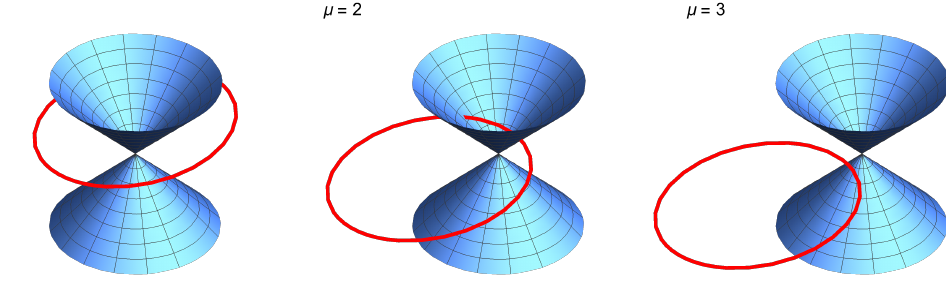
Figure 8: The space spanned by three of the free parameters of a two band matrix with AUS. The red loop represents x ( k ) as defined in eq. 19 for k ∈ ( 0, π ] and is drawn for three different values of µ . The cone is the set of points in parameter space where the band gap closes. At µ = 2 J in the intermediate regime (middle panel), x ( k ) intersects the cone at two exceptional points, at which it becomes